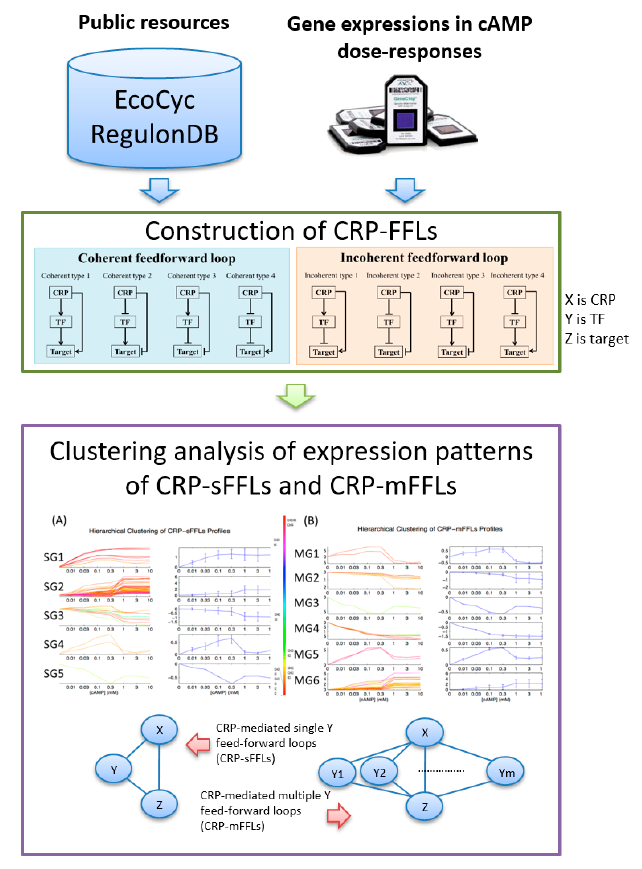
Figure 1. Data analysis flow of cyclic-AMP receptor protein–feed forward loops (CRP-FFLs). Data